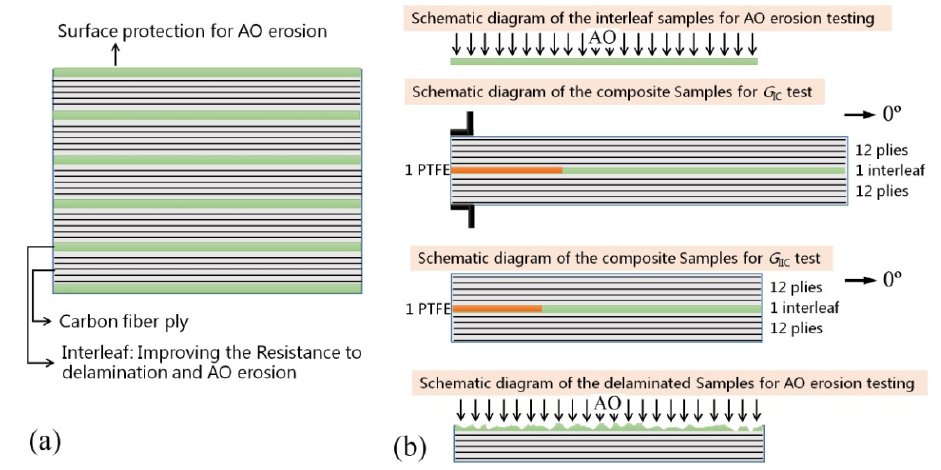
Figure 1. Schematic diagrams of the ( a ) design principle of the composite and ( b ) the testing samples.